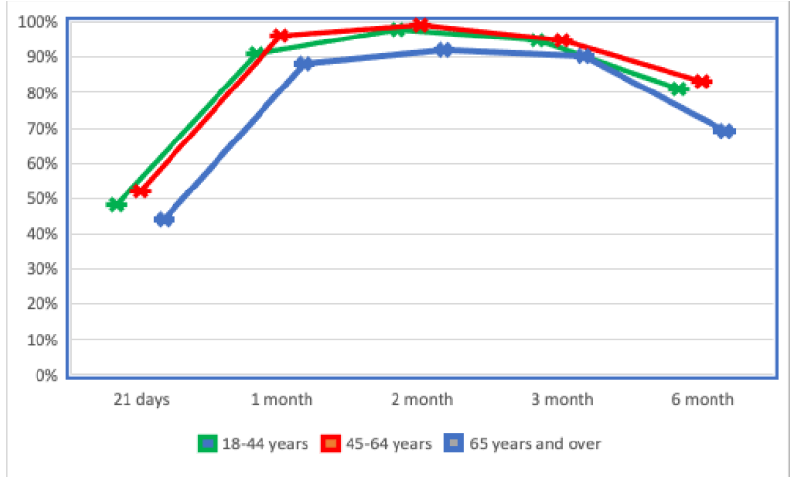
Figure 1. The proportion of seroconversions by age group. This figure shows the immune response against mRNA vaccines in the age groups, demonstrating how it is short-lasting in the group aged over 65 years of age.